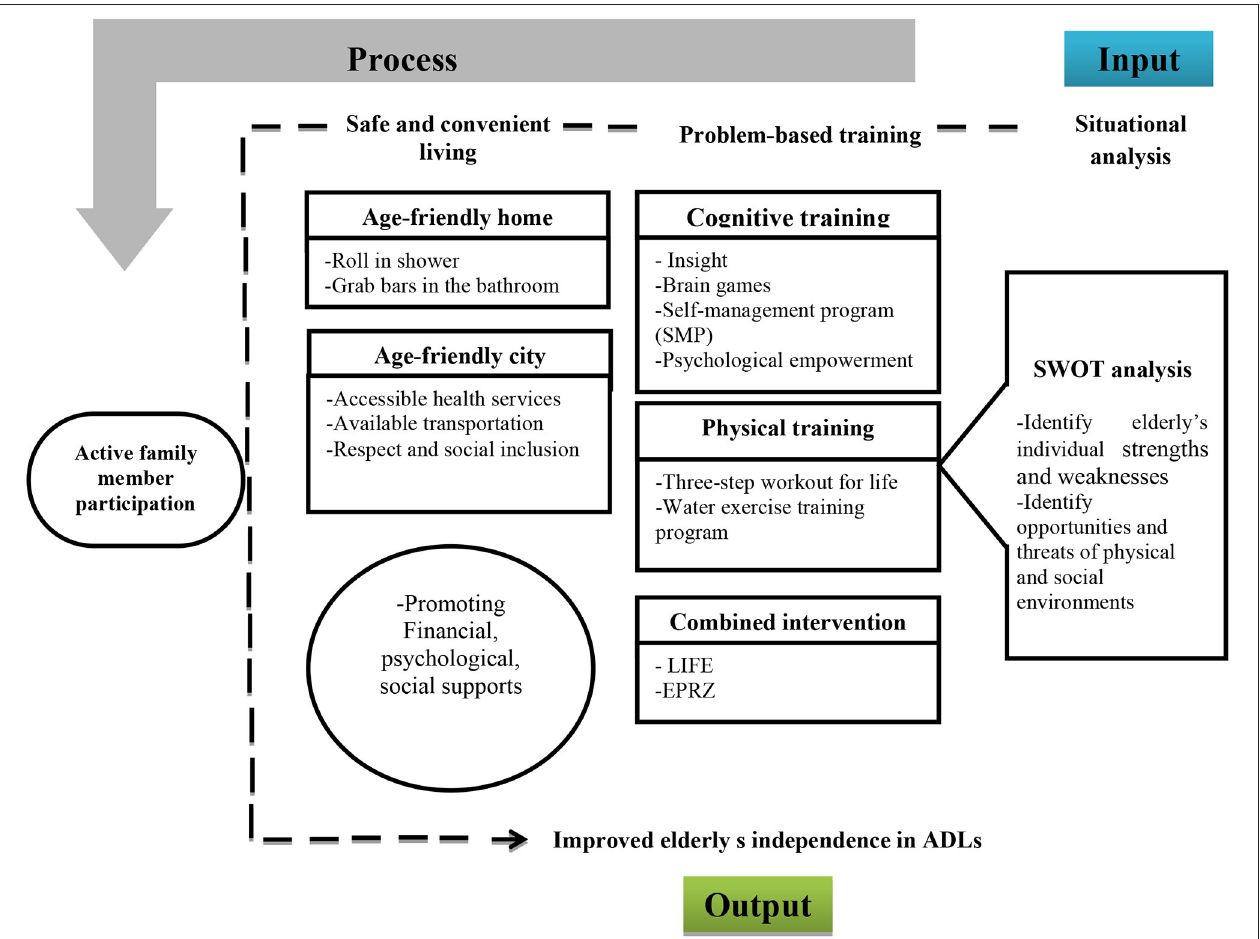
FIGURE 4 | Developing a logic model for improving elderly’s independence in